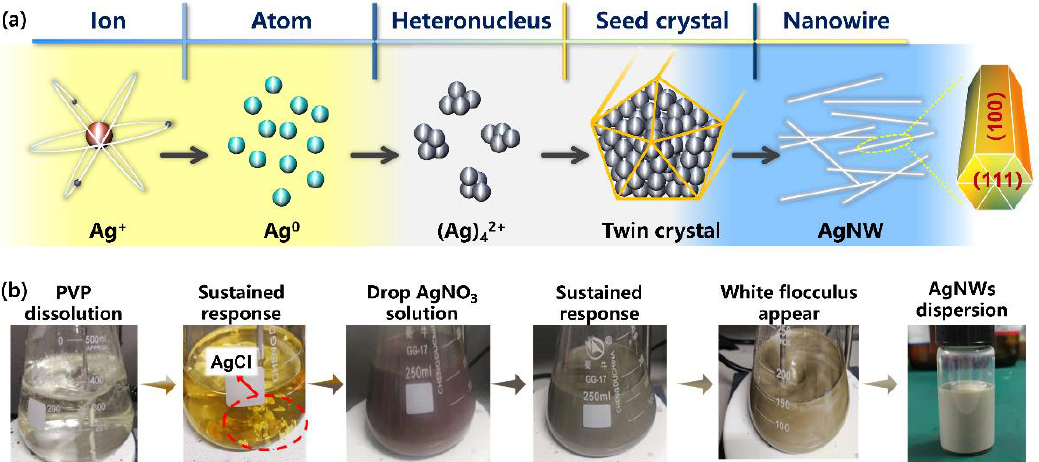
Figure 3. ( a ) Growth mechanism of AgNWs; ( b ) The color change of the reaction solution during the growth process.